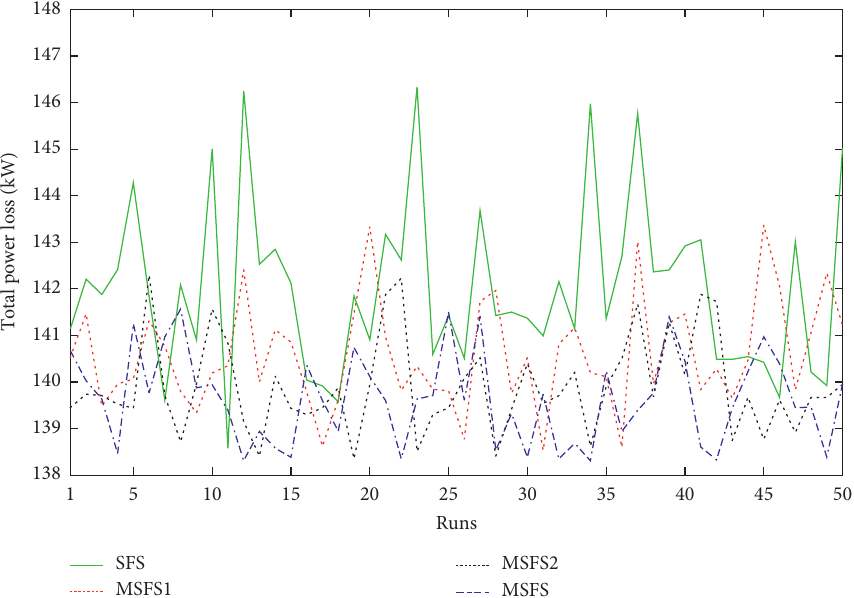
Figure 8: Total power loss of 50 trial runs obtained by SFS methods for case 2 of the 33-bus